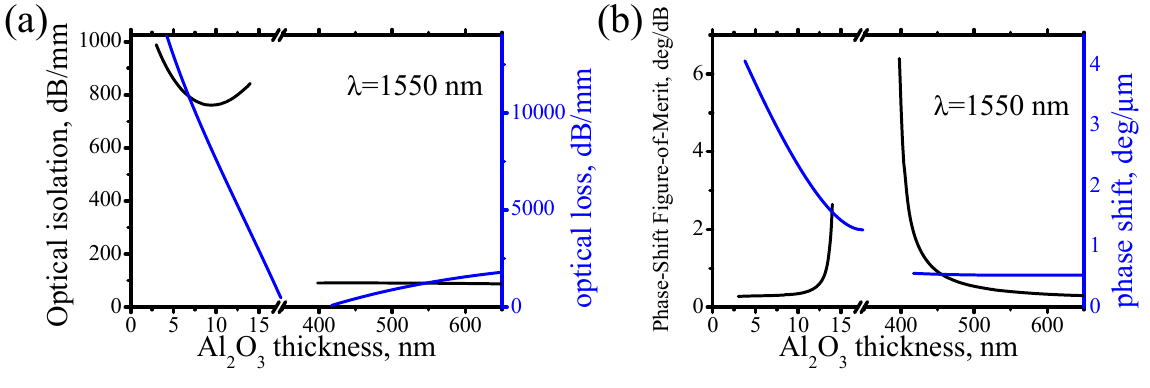
Figure 5. ( a ) Optical isolation and loss, and ( b ) non-reciprocal phase shift and Figure-of-Merit for the non-reciprocal phase shift for the surface plasmons in a Fe/Al plasmonic